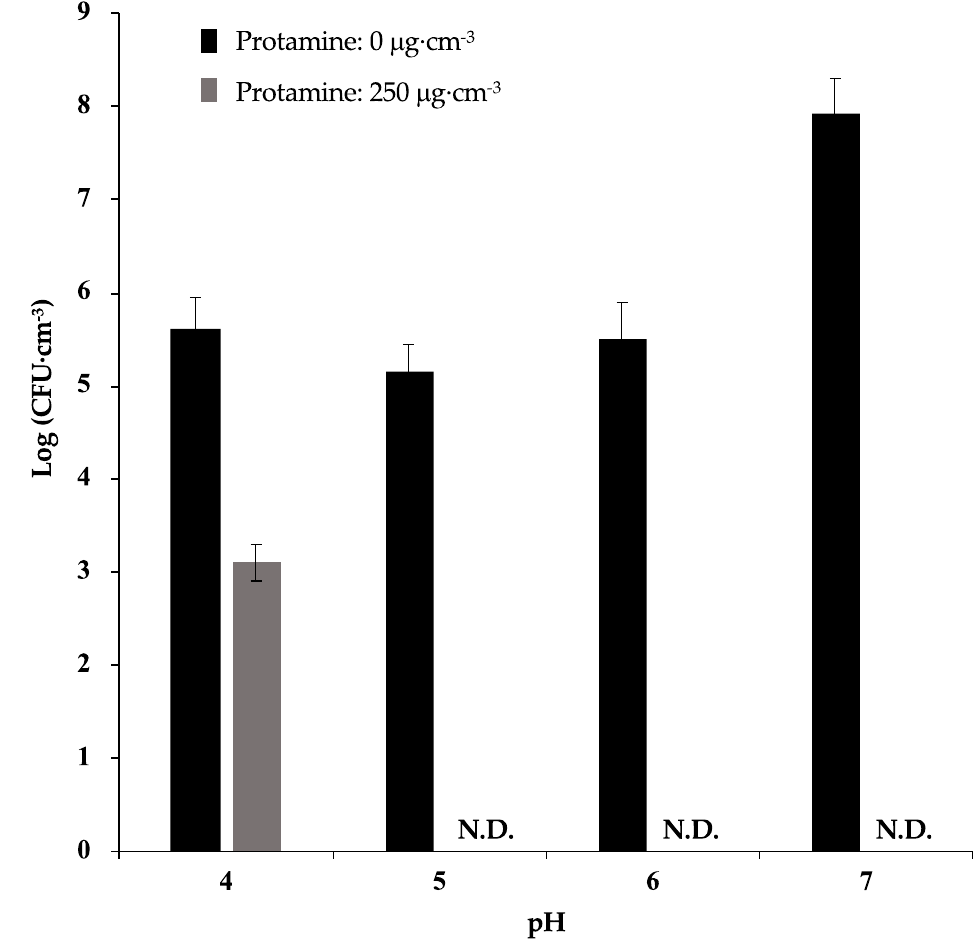
Figure 5. Effect of pH on antimicrobial activity of protamine. S. mutans (4×10 6 CFU·cm –3 ) were cultivated under different pH conditions for 24 h. After incubation, the number of bacteria was measured by colony counting. Error bars indicate the standard error of the mean ( n = 3).